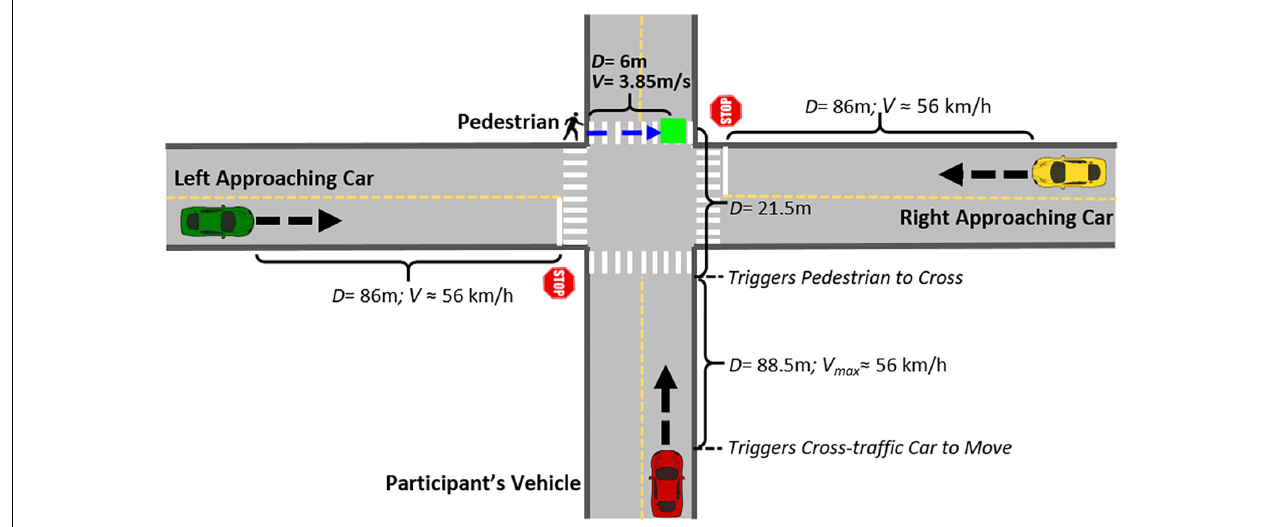
FIGURE 2 | Schematic representation of an intersection event for a scenario with a cross-traffic car approaching from the left and the right ( Scenario 3 in Figure 3 ). The green square represents the collision point between the participant’s vehicle and the pedestrian that starts approaching from the left after the participant’s vehicle enters the intersection. (D, distance and V,